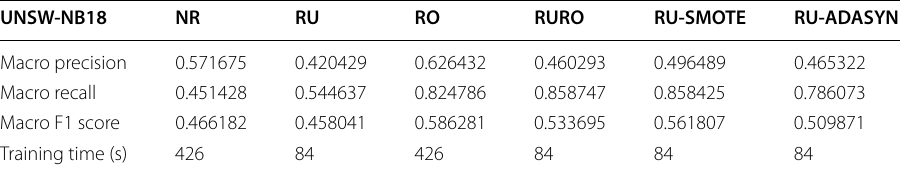
Table 29 ANN classification results for UNSW-NB18 (BoT-IoT) on AWS with Spark for various resampling methods